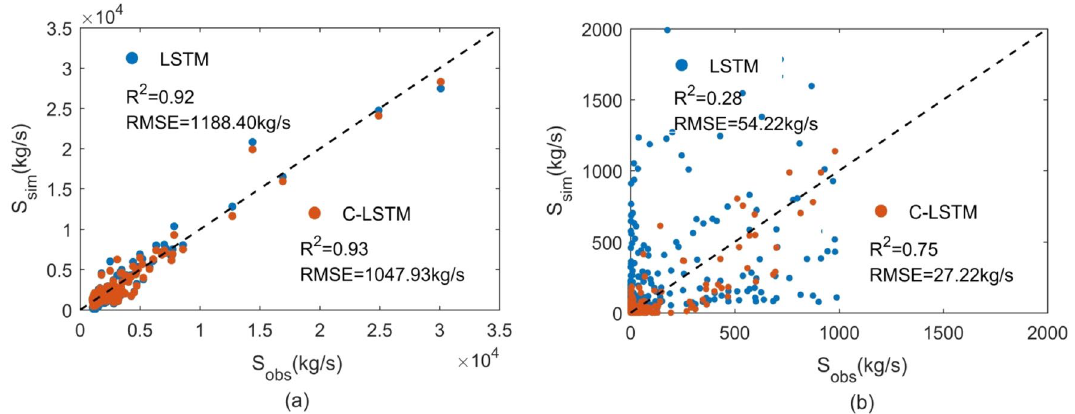
Figure 7. Scatter plot of observed and simulated of sediment for Patten1 ( a ) and Patten2 ( b ).